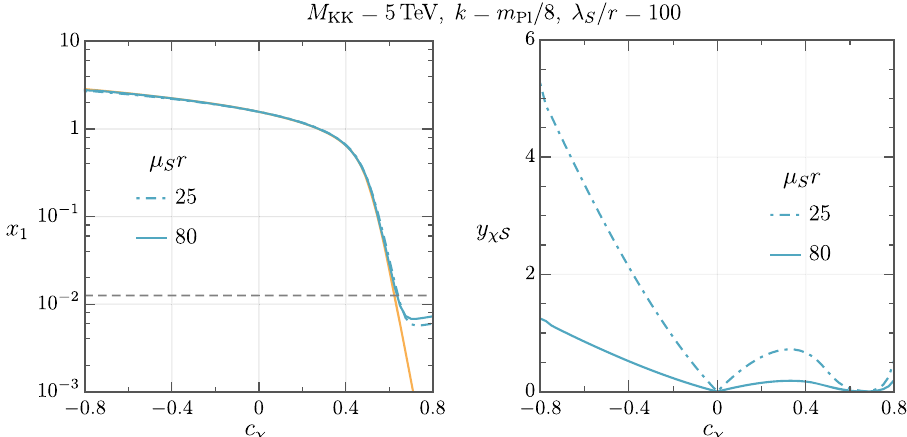
5D Lagrangian along with a sign function, as it is usual in RS models. We also show the value for which m χ = m h / 2 with a dashed gray line. Higgs decays into a pair of DM particles χ 1 ¯ χ 1 are kinematically allowed only if x 1 falls below this line. Right panel: value of y χ S as a function of c χ for the same choice of boundary conditions and values of μ S r